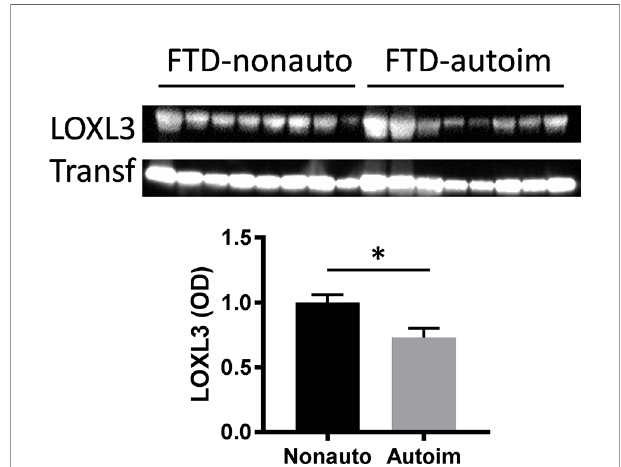
FIGURE 1 | Validation of LOXL3 alteration in bvFTD-autoimmune compared to bvFTD-nonautoimmune serum by western blotting; normalized to the